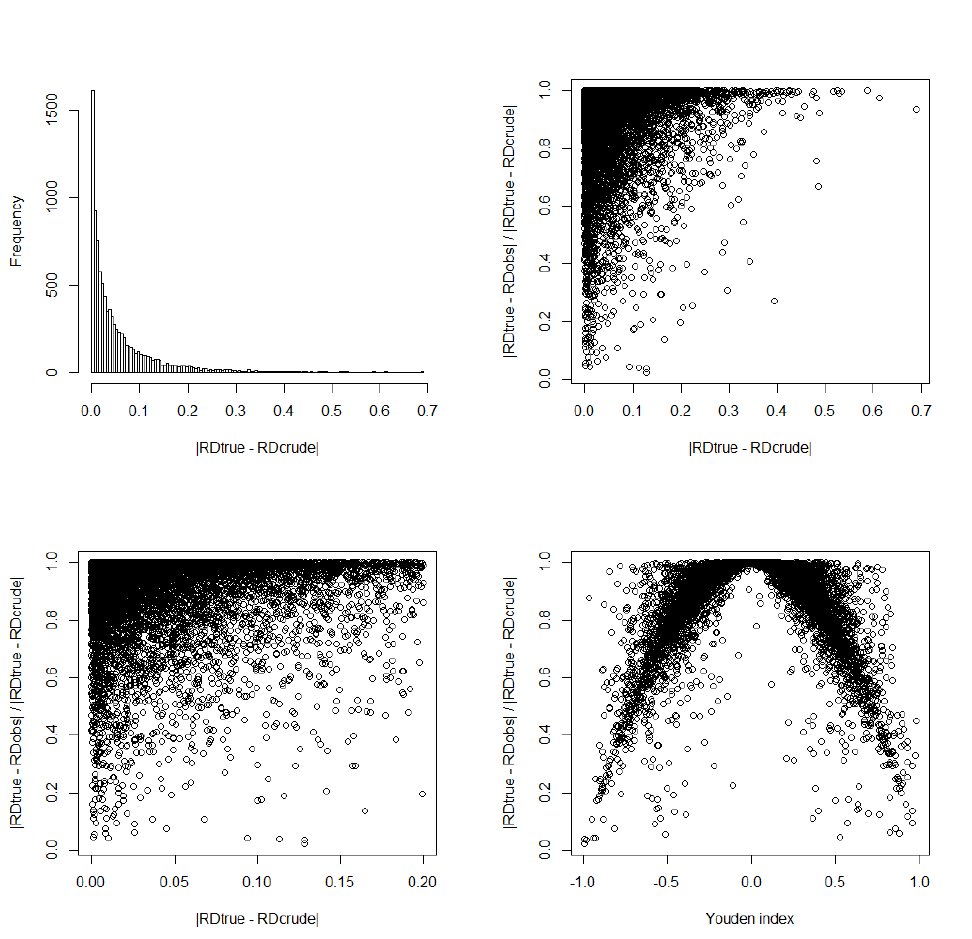
Figure 2: (tl) Histogram of interval length. (tr) Distance between RD obs and RD true relative to interval length. (bl) Zoom of previous plot. (br) Distance between RD obs and RD true relative to interval length, as a function of correlation between C and D when measured by Youden